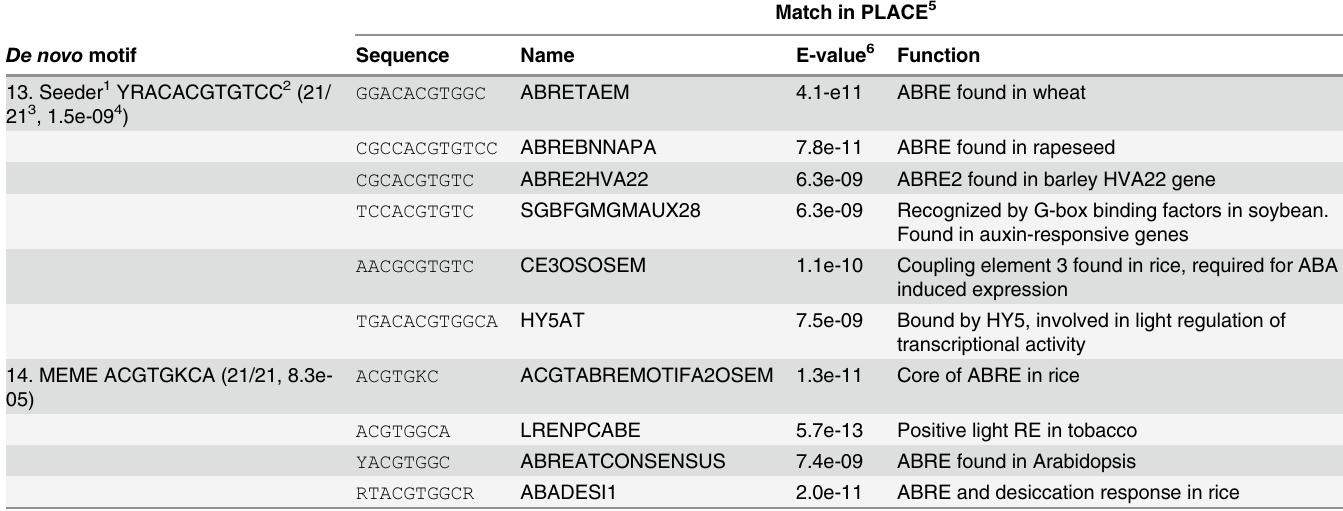
Table 6. Selected de novo motifs found in Y n K n dehydrin promoters and their putative function identified through PLACE